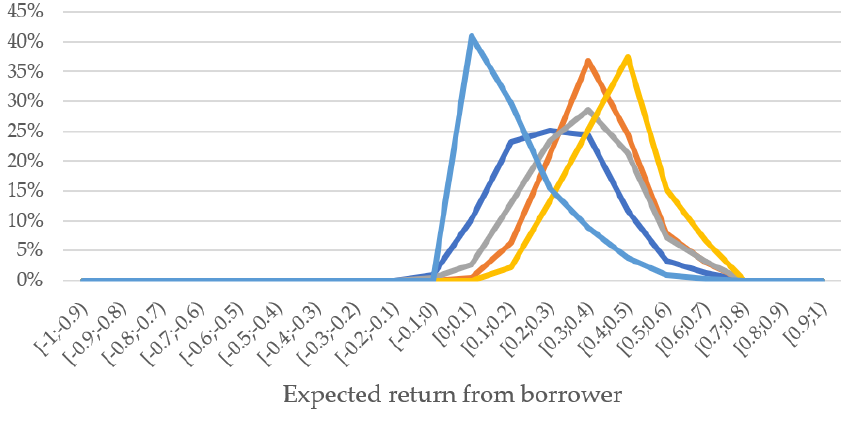
Figure 2. Comparison of E ( i ) > 0 approach and cut-off approach.